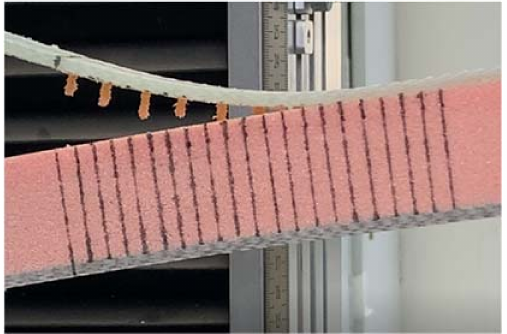
Figure 10. Testing of FH-10 specimen.